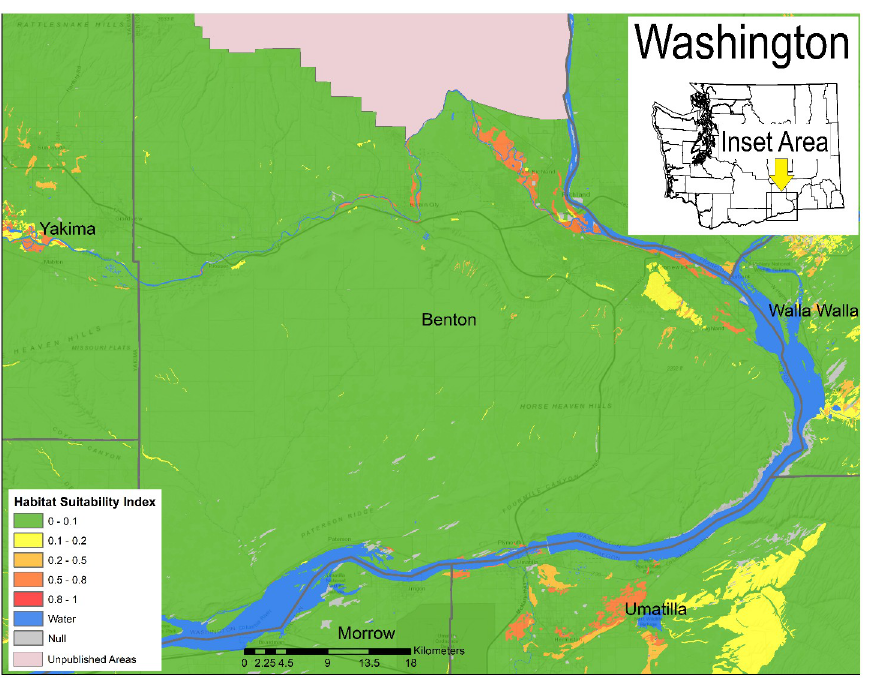
Fig 6. Predicted Coccidioides habitat suitability index for south-central